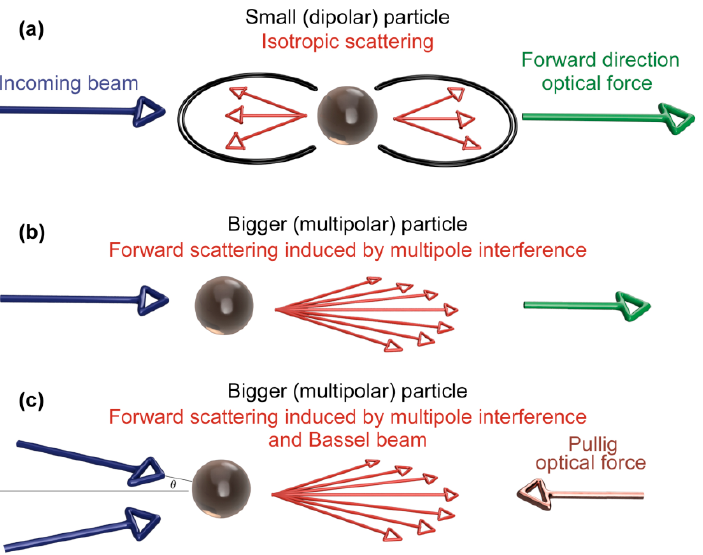
Figure 1. Scattering forces acting on rounded dipolar and multipolar metal nanoparticles. Isotropic scattering on small dipolar particles; arise of forward-directed optical force ( a ). Mutual interference between multipolar fields and particles in highly collimated beams; arise of reduced forward-directed optical force ( b ). Attenuation of radiation force with increasing angle between incoming beams; arise of optical pulling force ( c ).